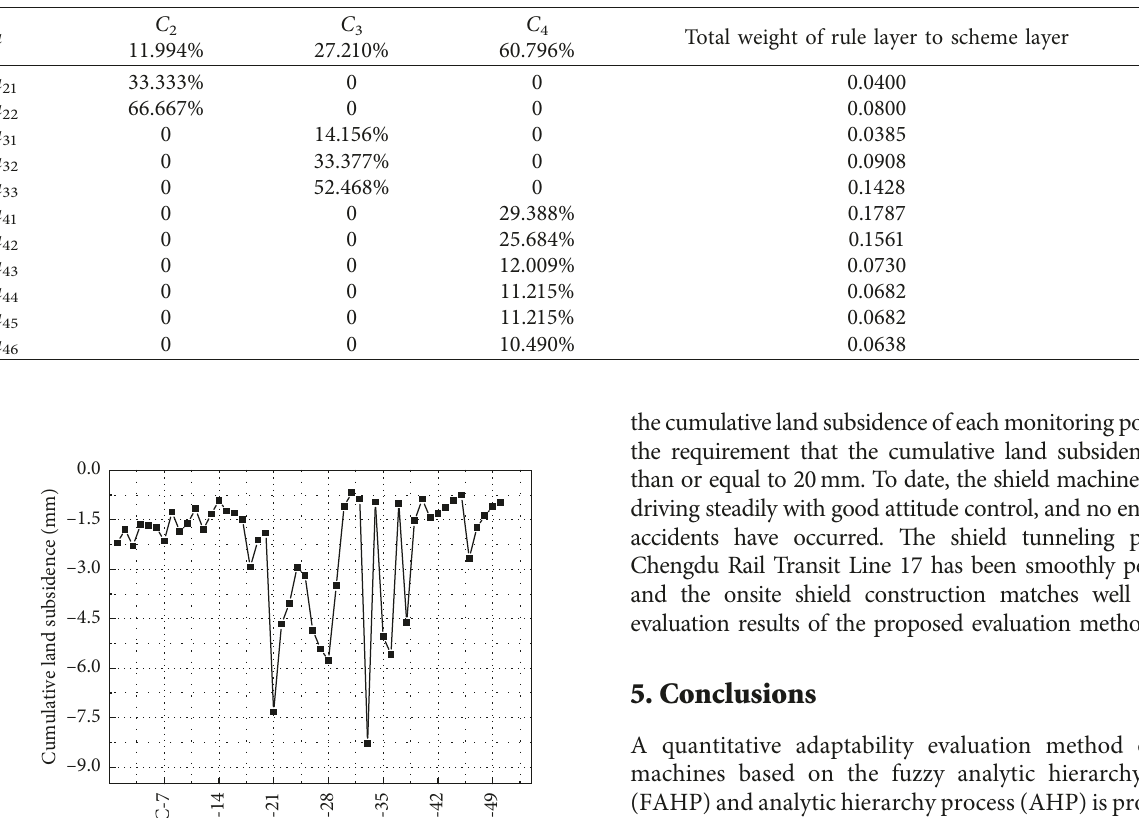
Table 12: Judgement matrix of the rule layer to the shield construction ( C